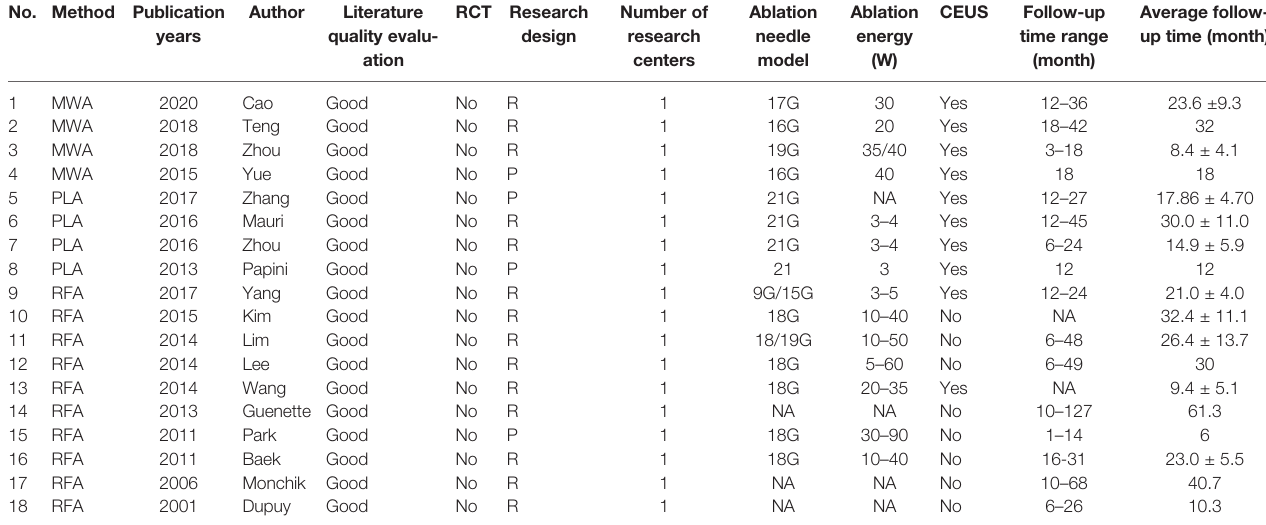
TABLE 1 | Basic characteristics of included